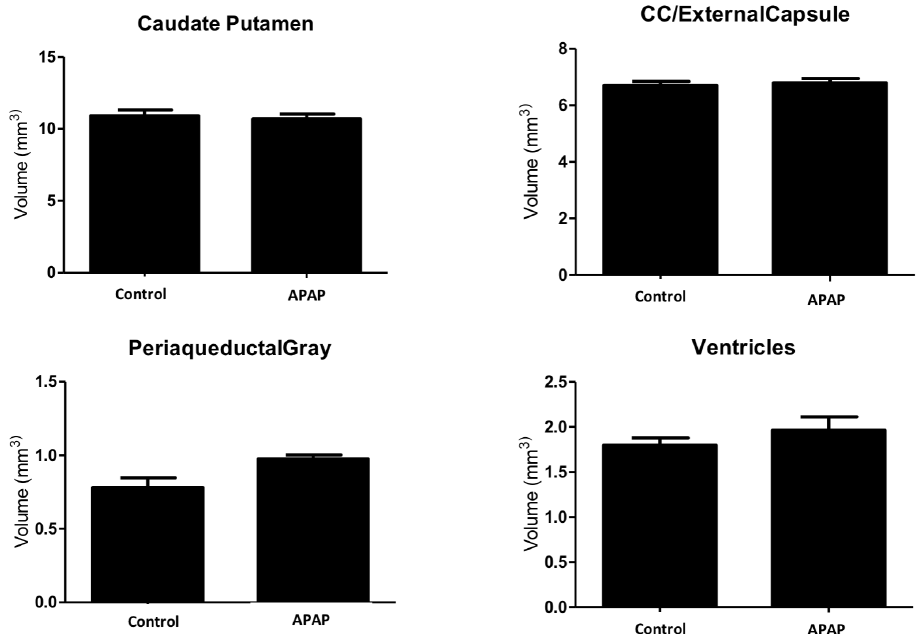
Fig 2. Computer-generated brain volumes of offspring mice as determined by MRI. MRI was done using 11.7 Tesla magnet and volumes of 29 brain areas were evaluated. No differences were found in volumes of brain locations of interest on MRI. Representative areas relevant to ADHD are illustrated. Data are presented as the mean ± s.e.m. Statistical significance was determined using Student ’ s unpaired t-test.